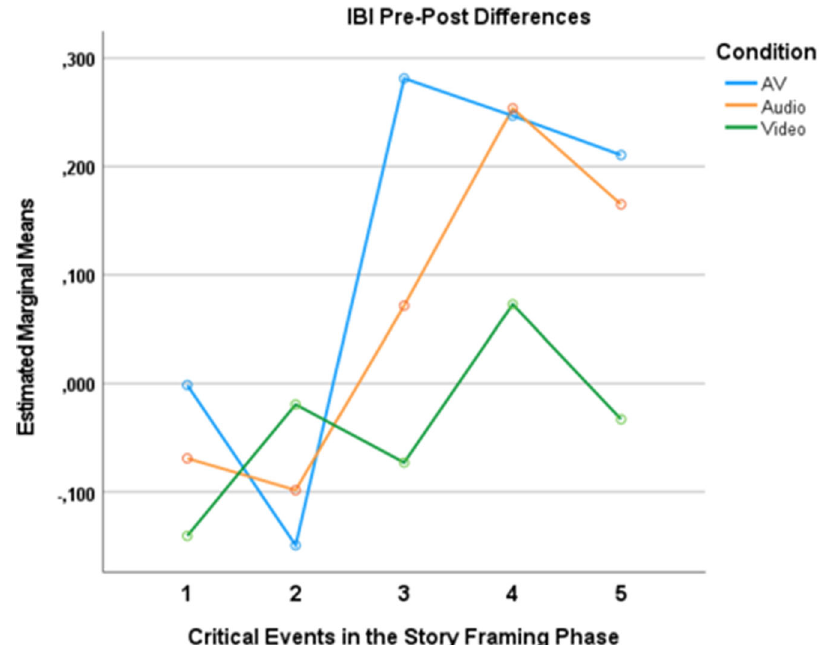
Fig. 4 Estimated marginal means of pre-post IBI differences (mean of 5 s before the critical event — mean 5 s after the event). Positive values indicate that IBI was lower after than before the event. Circles mark a signi fi cant difference from zero in the one-sample- t -test. Positive differences indicate that IBI was lower after the onset of the event than before, i.e., heart rate increased relative to the pre-value. See Supplementary Materials for a version of the fi gure that contains error